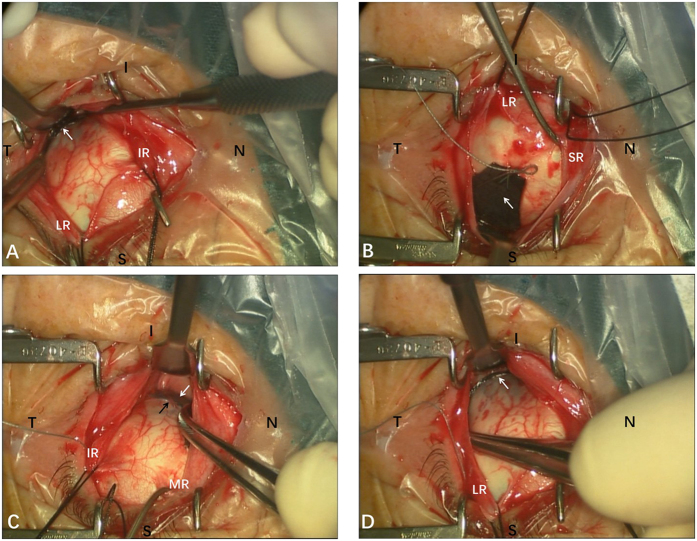
Intraoperative photographs of the posterior scleral contraction (PSC) surgery, the same case as in Fig. 2.(A) Ensured that the middle part of the sclera strip (white arrow) was placed at the posterior pole. (B) The superior temporal end of sclera strip (white arrow) was fixed to the pre-equatorial sclera, 2 mm behind and outside the insertion point of the superior rectus (SR) muscle. (C) The scleral strip (white arrow) was checked to assure that it was correctly positioned without damaging the vortex vein (black arrow). (D) Ensured that the sclera strip (white arrow) was stretched into a U shape to surround the posterior pole. S: superior; I: inferior; N: nasal; T: temporal; LR: lateral rectus; IR: inferior rectus; MR: medial rectus; SR: superior rectus.